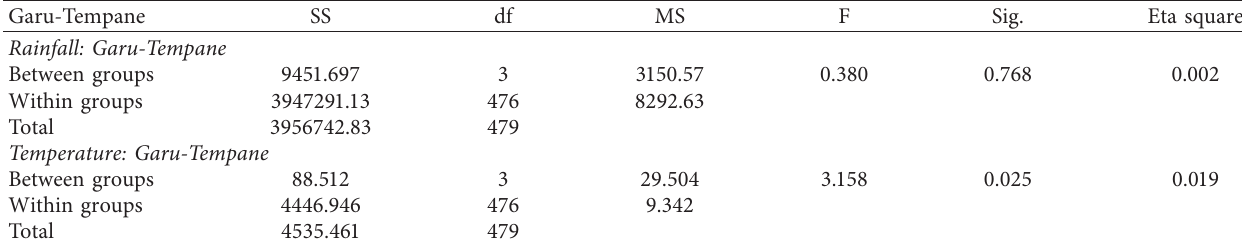
Table 8: ANOVA test statistics, Garu-Tempane.